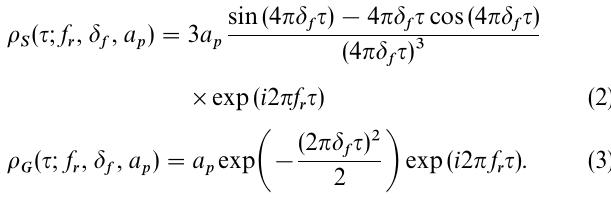
Fig. 4. Downshifted and upshifted spectra ( circle points and thin solid line ) from a 10-s dump fitted to the squared-triangle model ( thick solid line ) and the Gaussian model ( dashed line ). The scale is the same for each height